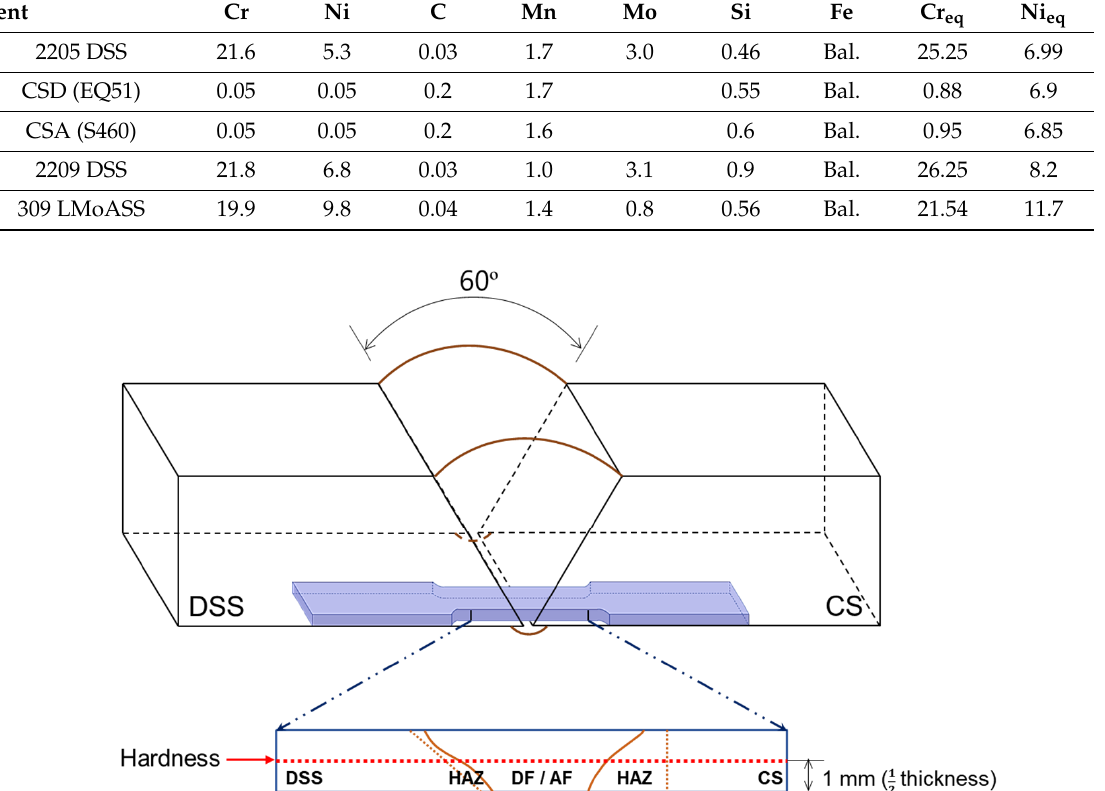
Figure 1. Schematic of the tensile specimens extracted from the welded joints (WJs) and the locations where the Vickers hardness was measured.